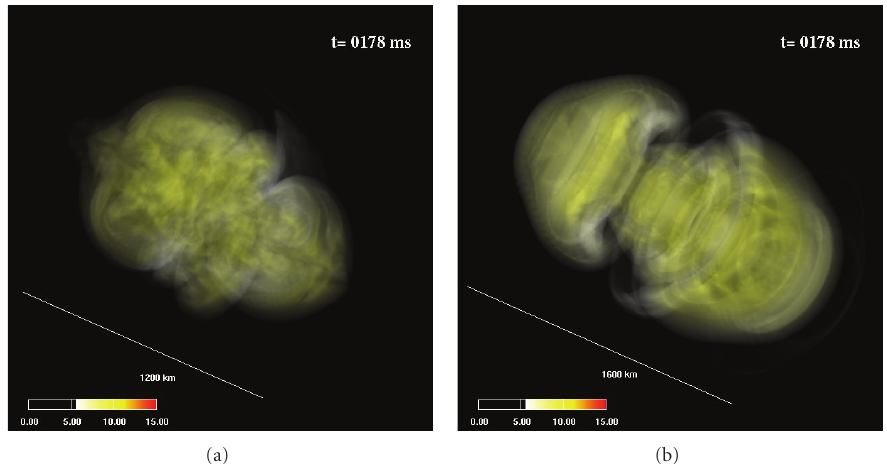
Figure 6: Volume rendering of entropy showing the blast morphology in our 3D (left) and 2D (right) model for the 11 . 2 M (cid:3) progenitor of Woosley et al. [118] (at t = 178 ms after bounce), respectively. The linear scale is indicated in each panel. These figures are taken from